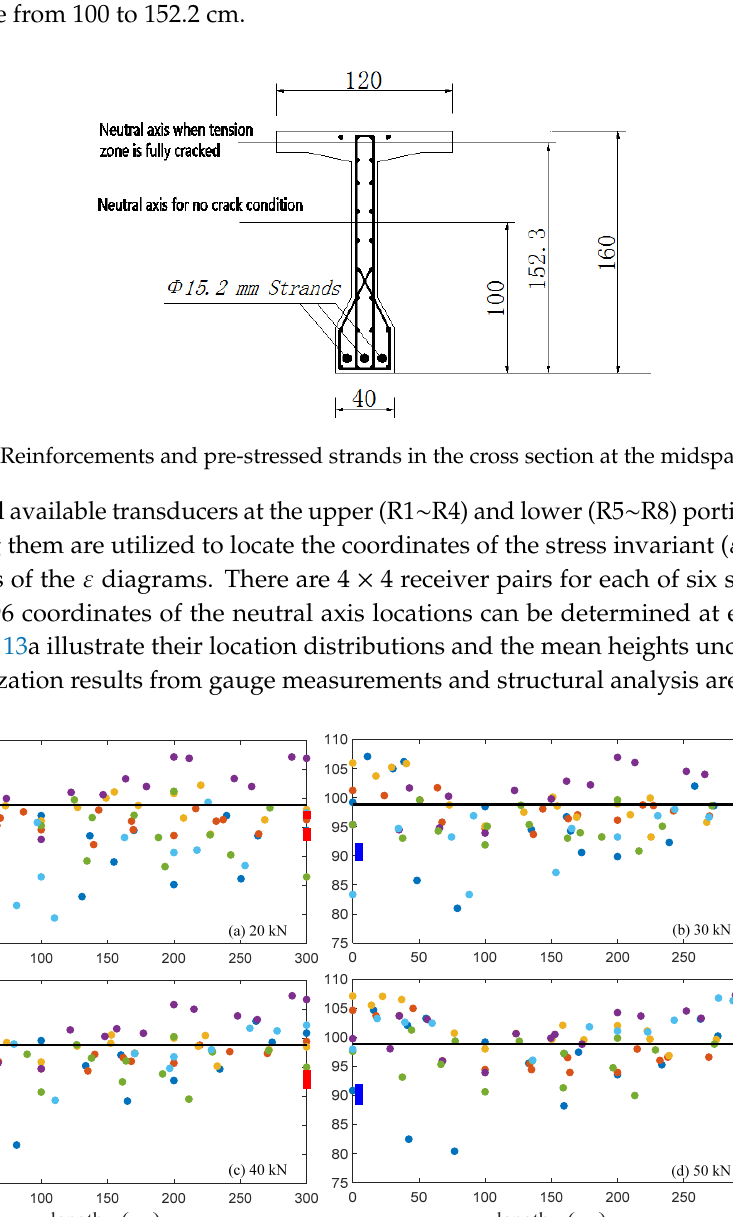
Figure 13. ( a ) The mean heights of neutral axis determined by transducers, gauges, and analysis, and ( b ) the neutral axis heights corresponding to each source excitation. 5.3. Localization of Micro-Cracks The mean heights of neutral axis determined by all available transducers evaluate global structural health. Further analysis with transducer networks, e.g., evaluate localization results from different source-receiver pairs, can locate inner micro-cracks up to a certain extent. Figure 13b shows an example of the mean heights under varied loads corresponding to each source excitation. The S1, S2, and S5 heights keep lower than the analysis value, whereas the S3 and S4 heights are always higher than the analysis value. All of their heights are varied in a limited range of 1 ∼ 3 cm as loads increase. Thus, the region between S3 and S4, either at the surface or inside concrete, contains damages. Additionally, the damages are not significantly worsened during the loading procedure. Furthermore, the S6 heights increase linearly as loads, and its height at 50 kN exceeded the associated S3 ∼ S4 heights, which indicates that the outer part of the S6 position experiences the cracking effect during the loading procedure. These predictions are very consistent with our observations presented in Figure 5. In particular, the ultrasonic transducers are placed at the T-beam’s east face without cracks, but, at the opposite west web, one crack (crack 1) exists in the region between the S3 ∼ S4 locations and two cracks (cracks 2 and 3 at the bottom) near S6 gradually get bigger under loading. The localization results of neutral axis by a network of transducers indicate rough positions of multiple micro-cracks. More transducers and closer placement as well as analysis of different source- receiver pairs (i.e., sensor network) can lead to higher resolution. In a recent study, several other coda wave-based techniques such as maximum likelihood [23] and diffusion imaging [24–26] are